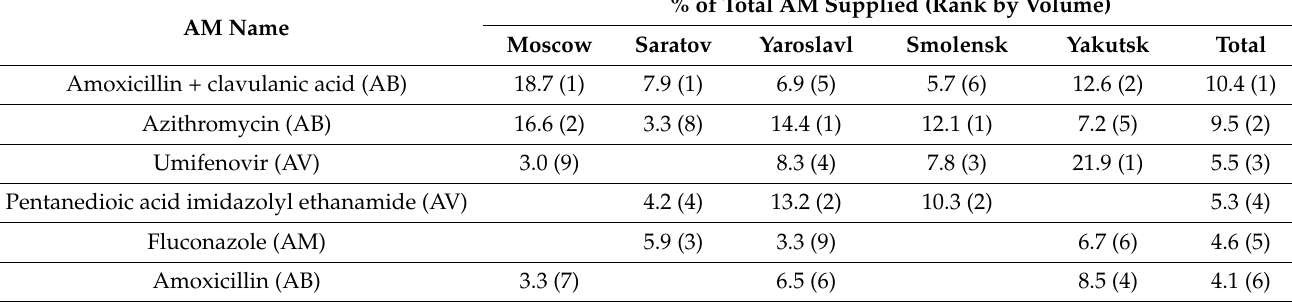
Table 5. Top 10 AM agents supplied in community